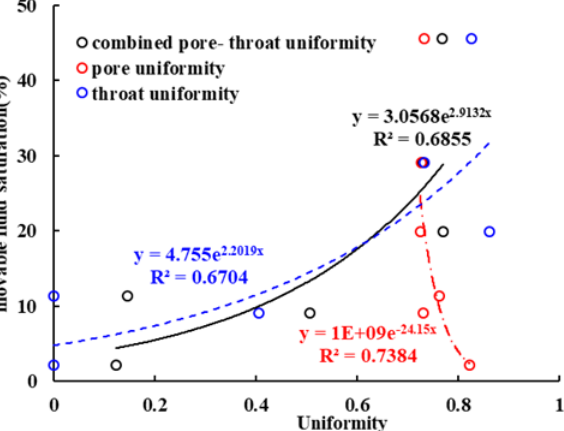
Figure 3. Relationship between movable fluid saturation and pore uniformity, throat uniformity, combined pore-throat uniformity .